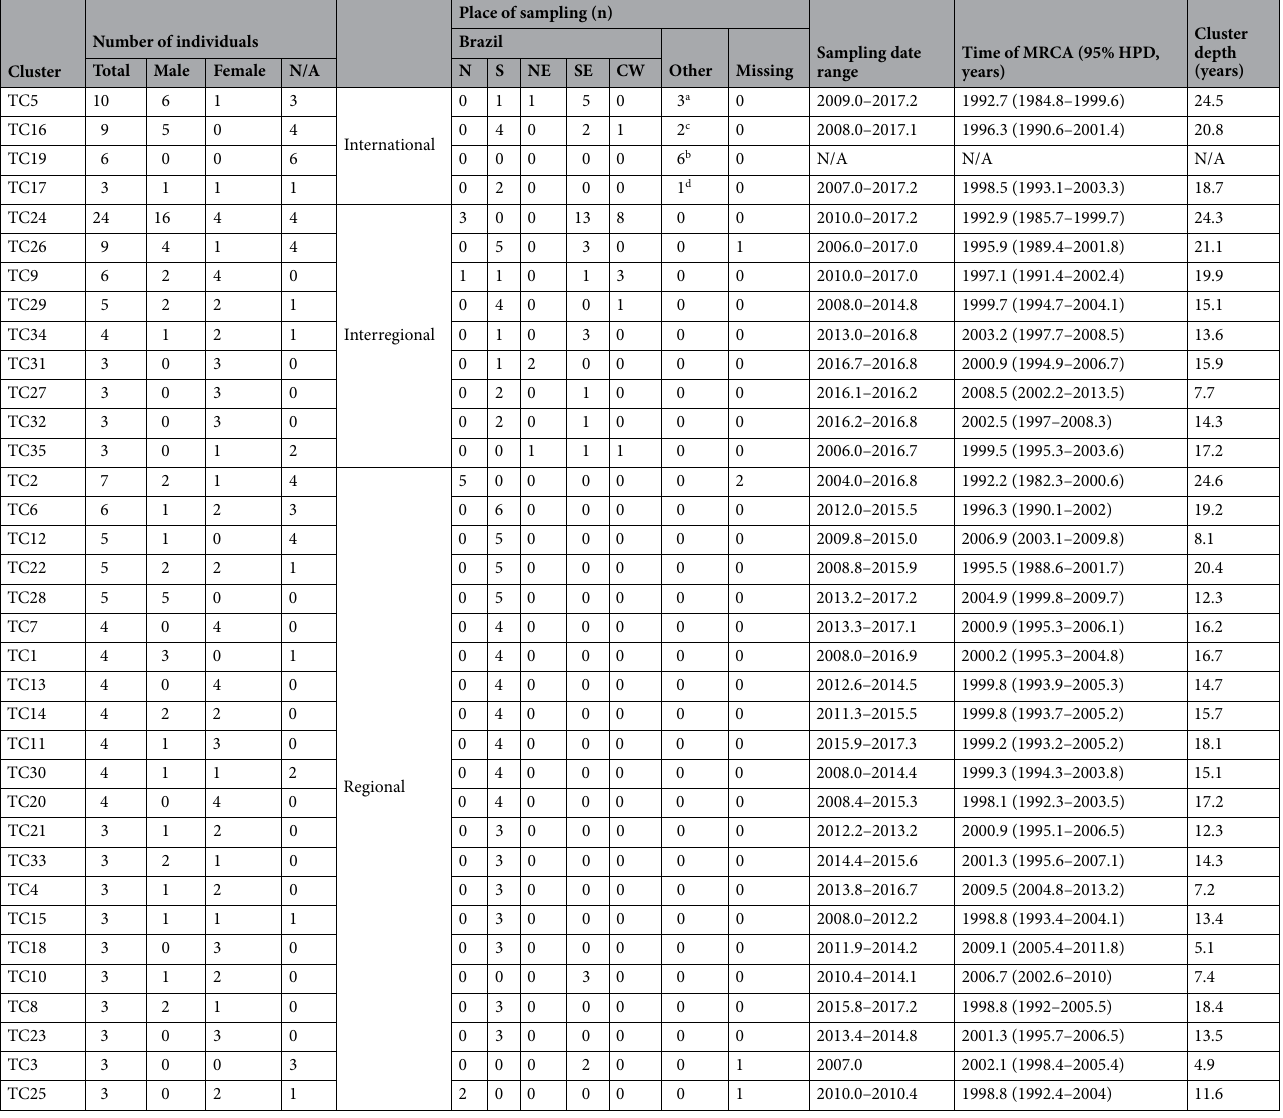
Table 1. Characterization of the 35 transmission clusters of HIV-1 subtype C virus identified in this study. a USA (1), Spain (1), Portugal (1). b UK (6). c Germany (1), Spain (1). d Germany